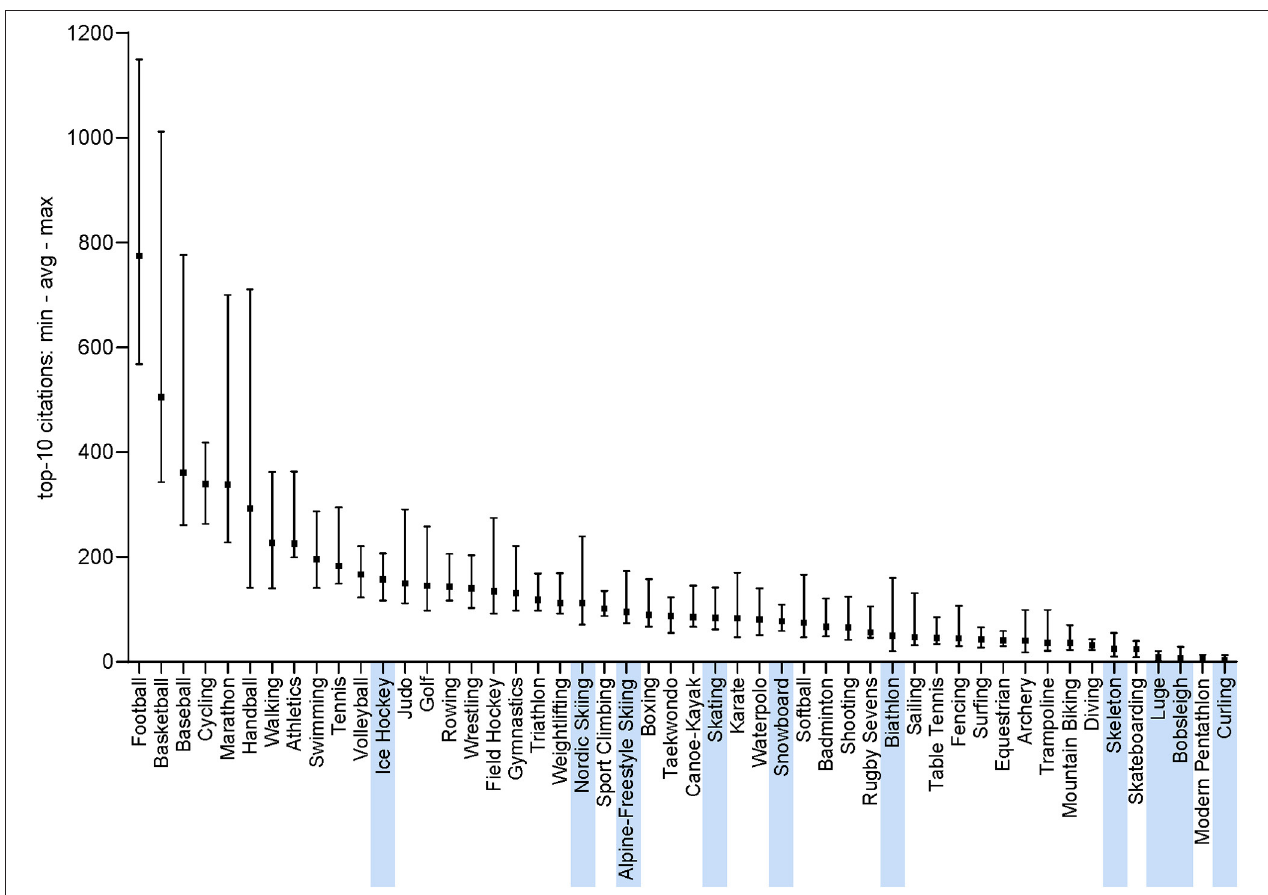
FIGURE 4 | Maximum (upper boundary), average (square) and minimum (lower boundary) numbers of citations of the top-10 publications of each sport. Winter sports are